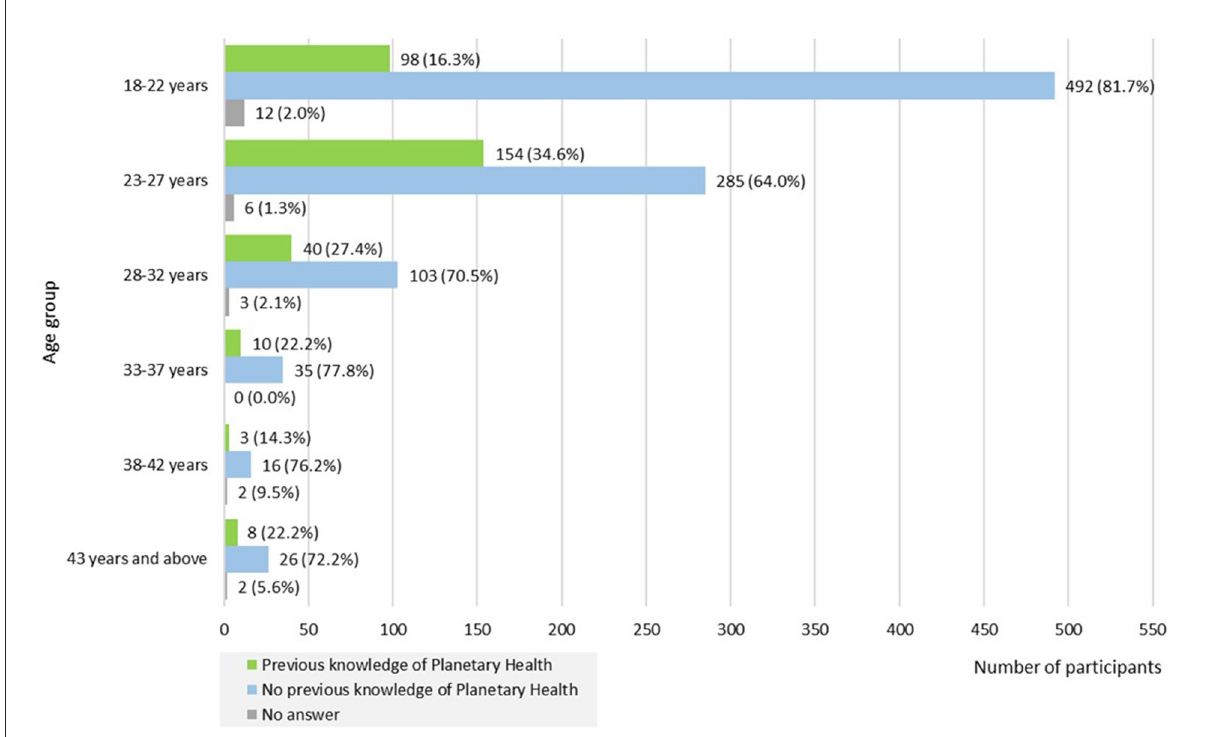
FIGURE1 Previous knowledge of Planetary Health stratified by age group ( N = 1,303).